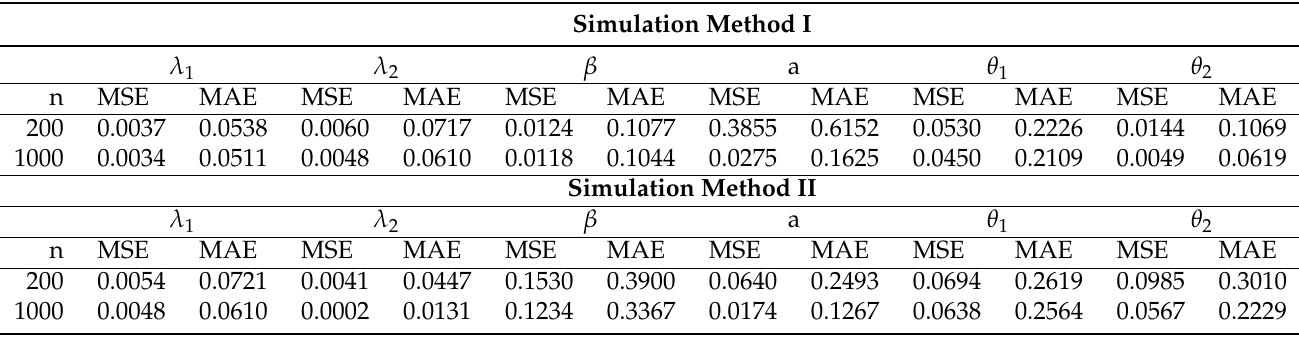
Table 1. Simulation results with 100 replicas for MSE and MAE with sample sizes n = 200 and n = 1000.